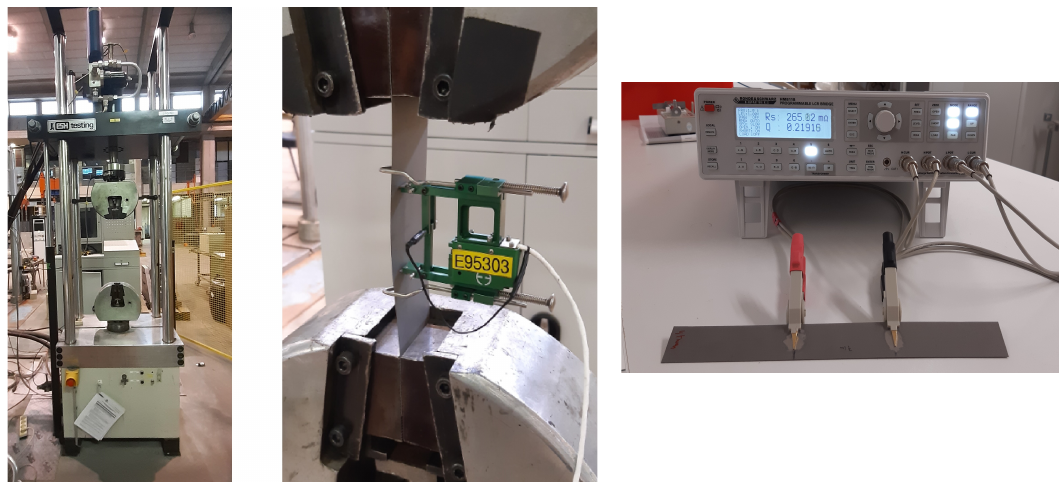
Figure 4. ( Left ): MTS tensile tester setup for measuring the stress strain curve. ( Middle ): extensometer attached to sample in tensile tester. ( Right ): Experimental setup for measuring the electrical resistance using the 4-wire